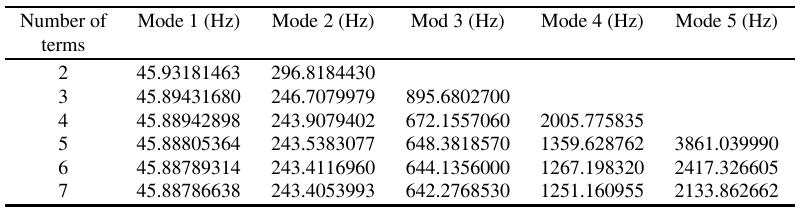
Table 7 Convergence of natural frequencies as a function of number of terms in the polynomial shape